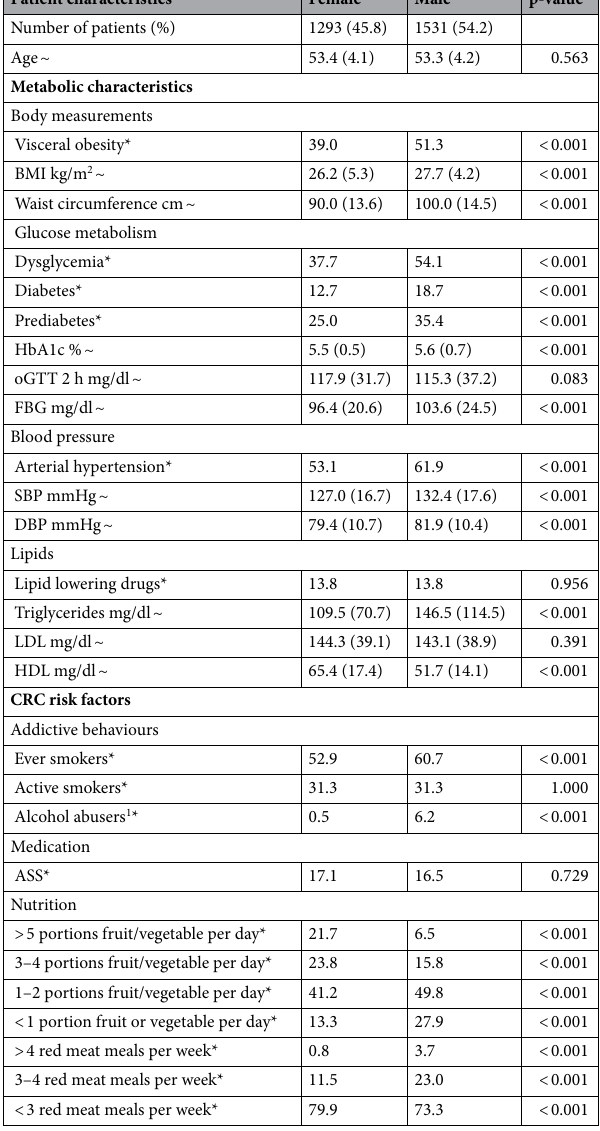
Table 1. Baseline characteristics of patients grouped by sex. BMI body mass index; oGTT oral glucose tolerance test; FBG fasting blood glucose; SBP systolic blood pressure; DBP diastolic blood pressure; LDL low density lipoprotein; HDL high density lipoprotein; ASS aspirin. *Numbers expressed as percentage; ~ numbers expressed as mean with standard deviation (in brackets). 1 > 30 g/day and > 20 g/day for males and females, respectively.